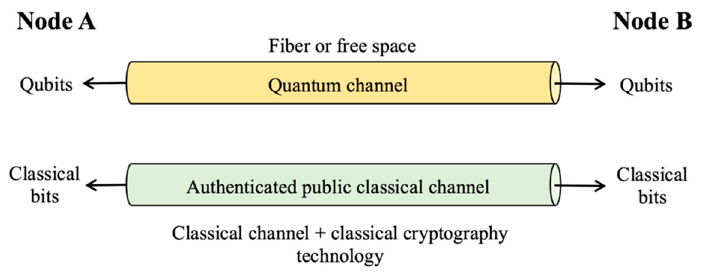
Figure 2. Schematic diagram of the quantum link.